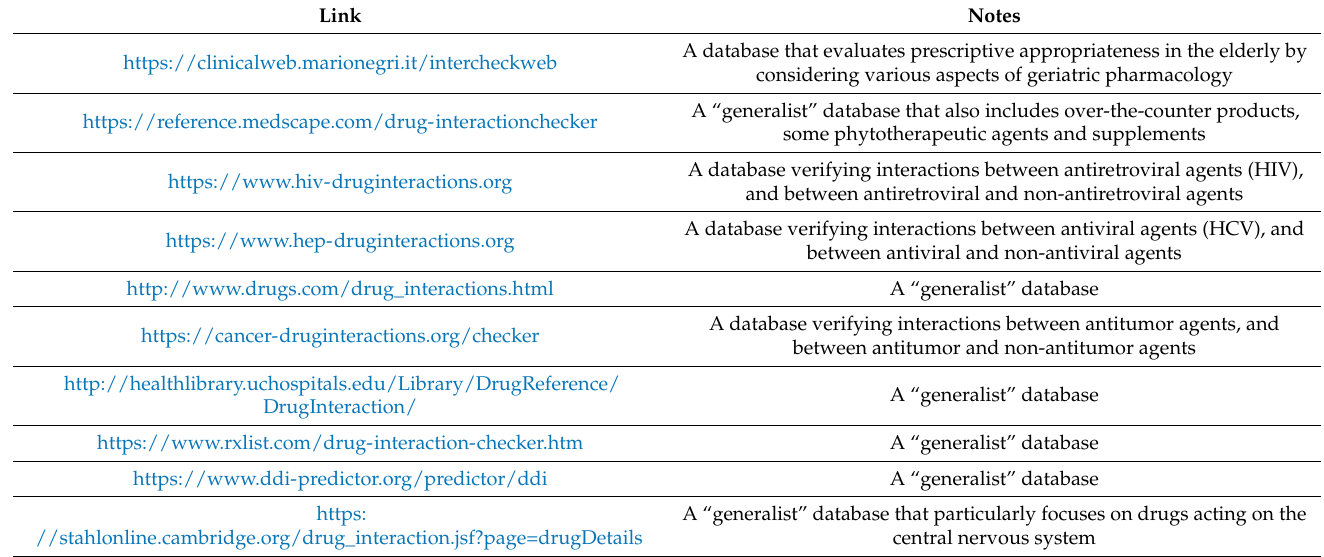
Table 3. Some of the free web databases that can be used to verify potential drug-drug interactions (pDDIs).